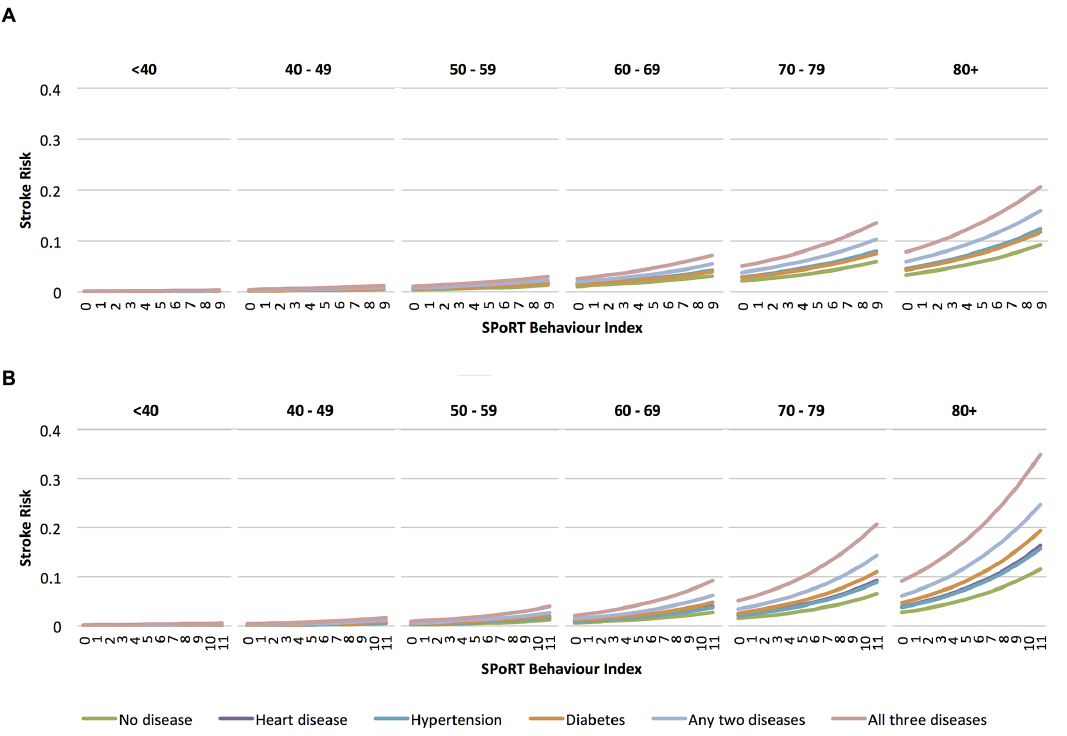
Fig 4. Secondary analysis — observed (O) versus predicted (P) risk of 5-year incident stoke by risk decile, combined development and validation cohorts. Panel A = males; Panel B = females. Abbreviations: O = observed; P = predicted. * Primary outcome.